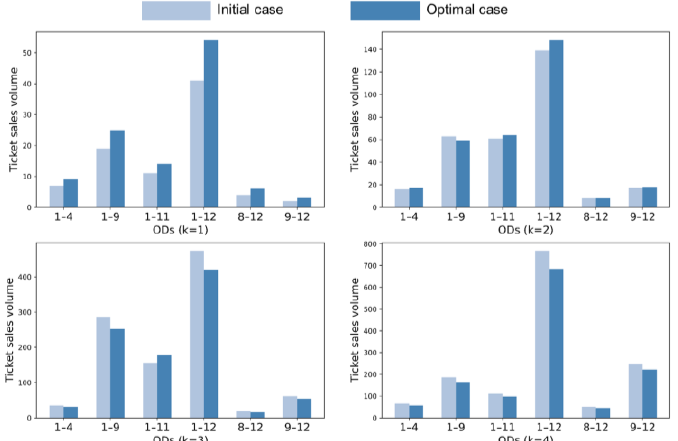
Figure 9. Comparison of ticket sales volume for different ODs in different periods.